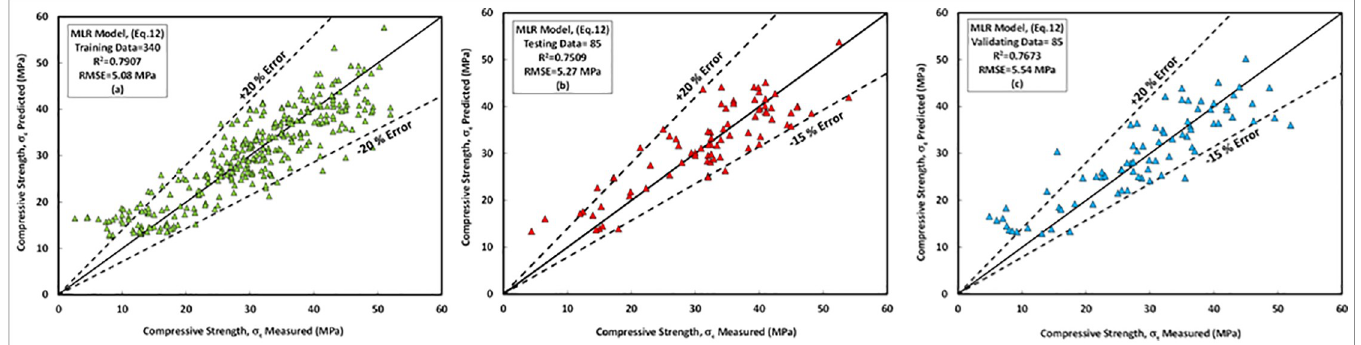
Fig 19. Comparison between measured and predicted compressive strength of fly ash-based geopolymer concrete mixture using MLR model, (a) training data, (b) testing data, (c) validating data.